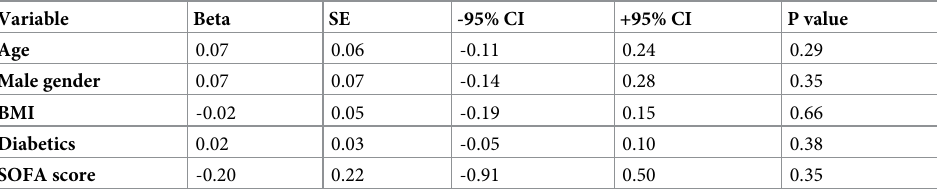
Table 5. Meta-regression